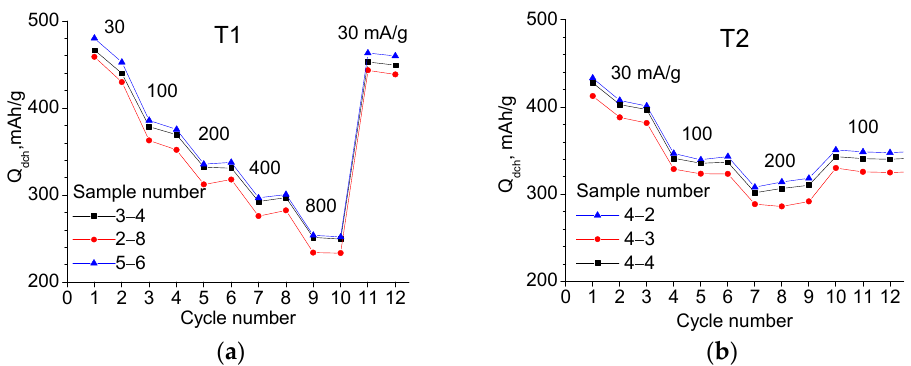
Figure 4. Coulombic efficiency of three T2 samples at current density j = 100 mA/g ( a ) and one T1 sample at j = 400 mA/g ( b ) as a function of cycle number.